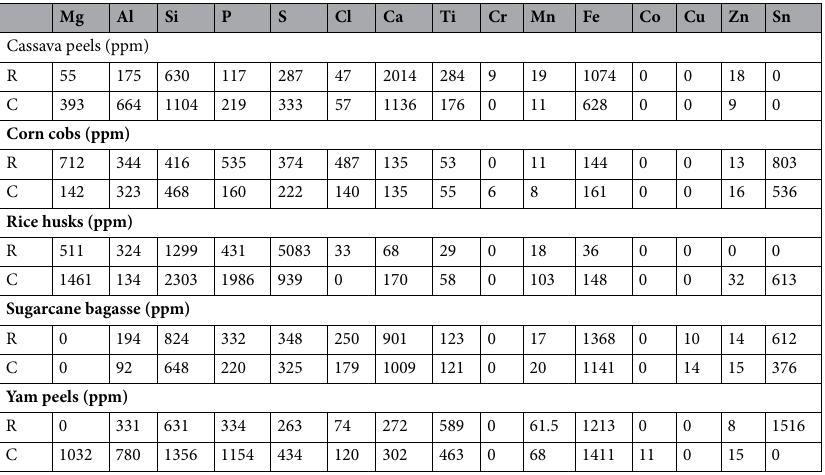
Table 6. Effect of hydrothermal pretreatment on the raw biomass samples. R—Raw biomass sample. C— Hydrothermal